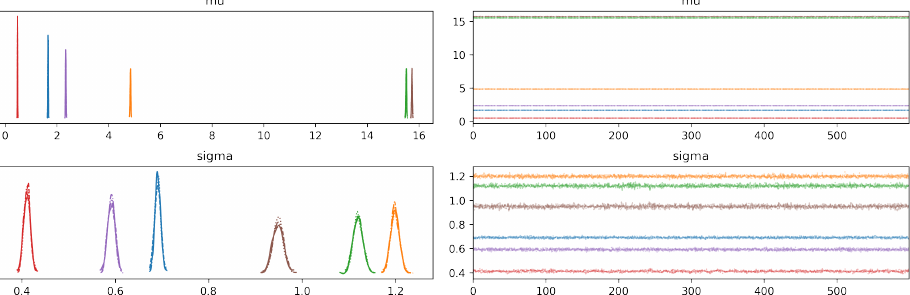
Figure 6. Inference model graph for INSEE dwelling categories. × represents the product of dimensions.